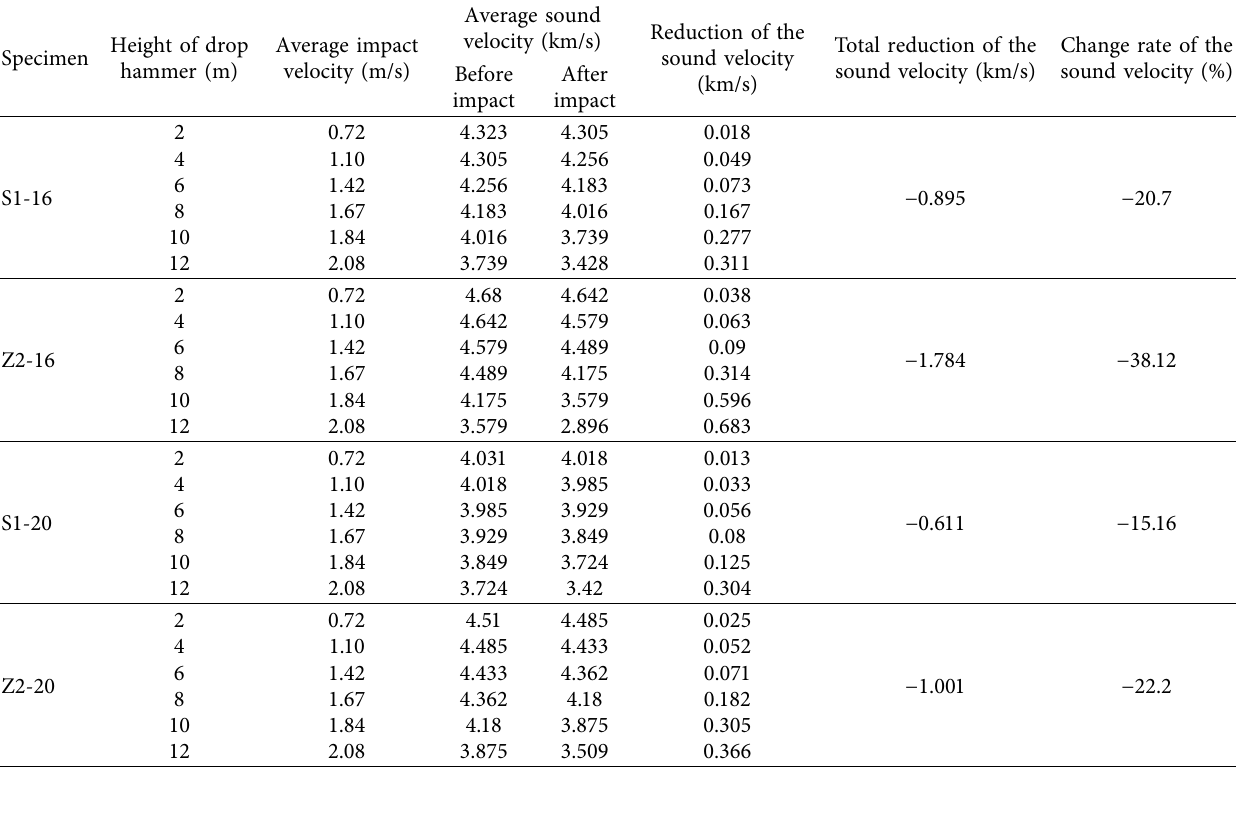
Table 9: Changes in the ultrasonic speeds of the concrete.